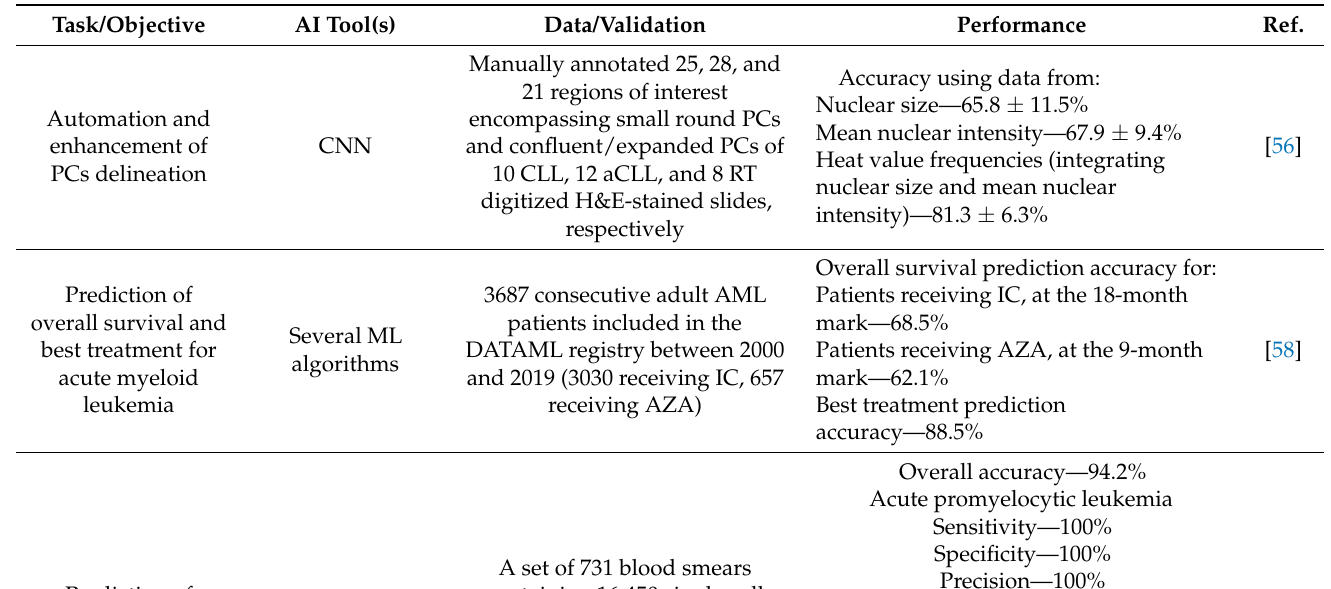
Table 5. Summary of the recent AI studies in